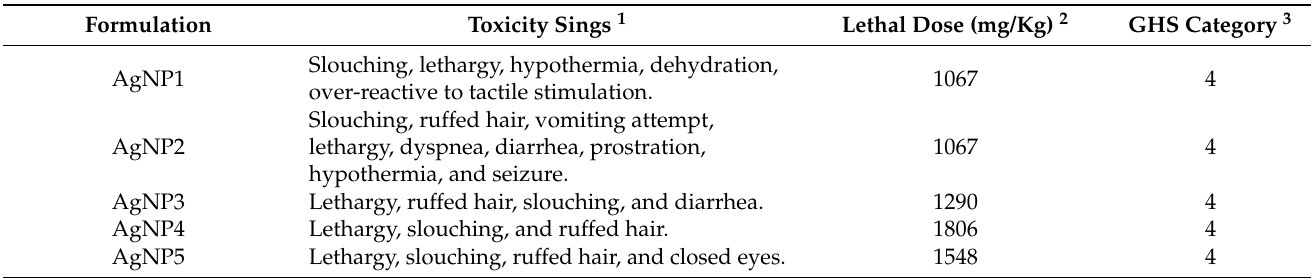
Table 2. Toxicity signs and median lethal dose (LD 50 ) of AgNP formulations assessed in this work. Formulation Toxicity Sings 1 Lethal Dose (mg/Kg) 2 GHS Category 3 Slouching, lethargy, hypothermia, AgNP1